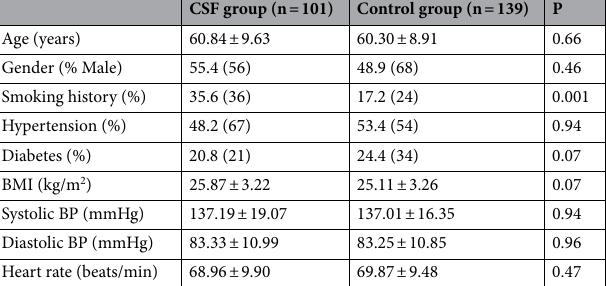
CSF group (n = 101) Control group (n = 139)